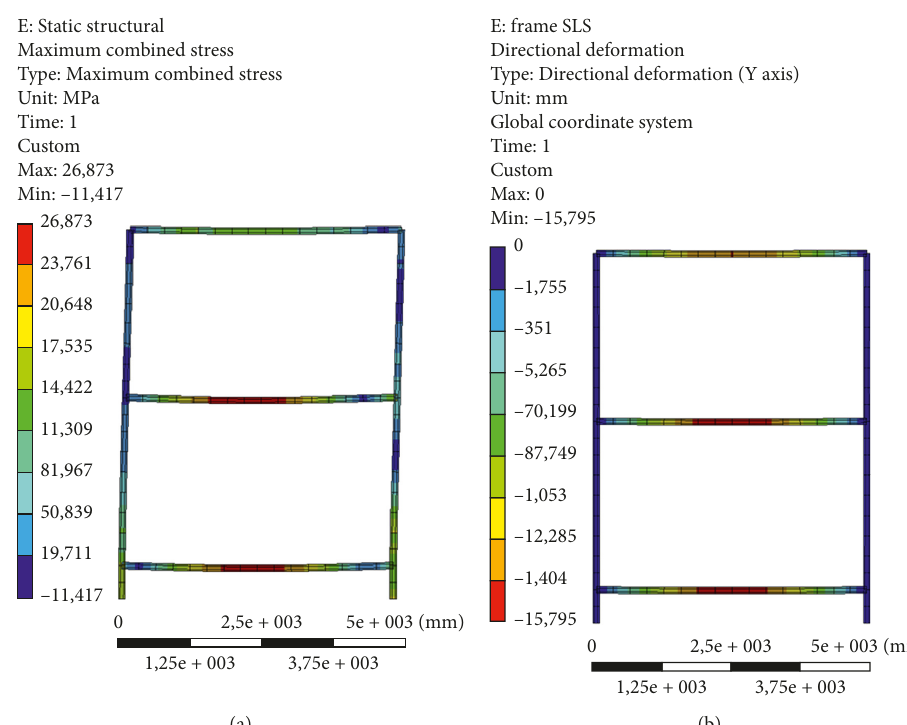
Figure 22: Results in a main 2D frame with plane joints. (a) Combined stress and (b) directional deformation.